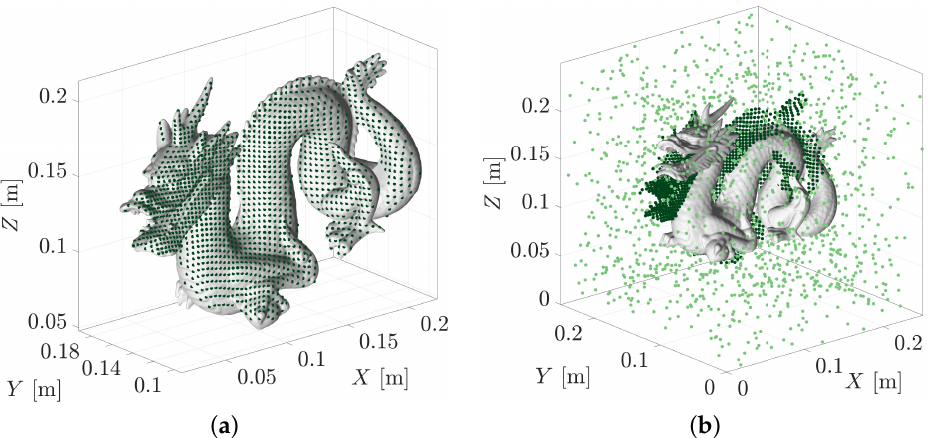
Figure 21. The ICP point-to-plane fit is unable to determine the pose of the model in the cluttered point cloud. ( a ) ICP point-to-plane fit of Stanford Dragon model to segmented point cloud. ( b ) ICP point-to-plane fit of Stanford Dragon model to the same point cloud with an equal number of uniformly random measurements (i.e., 50% clutter).